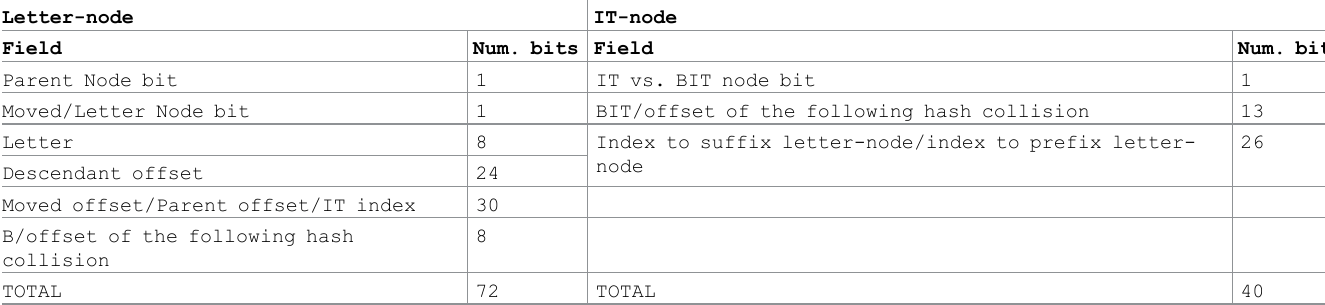
Table 1. C++ bit fields used in the MergedTrie